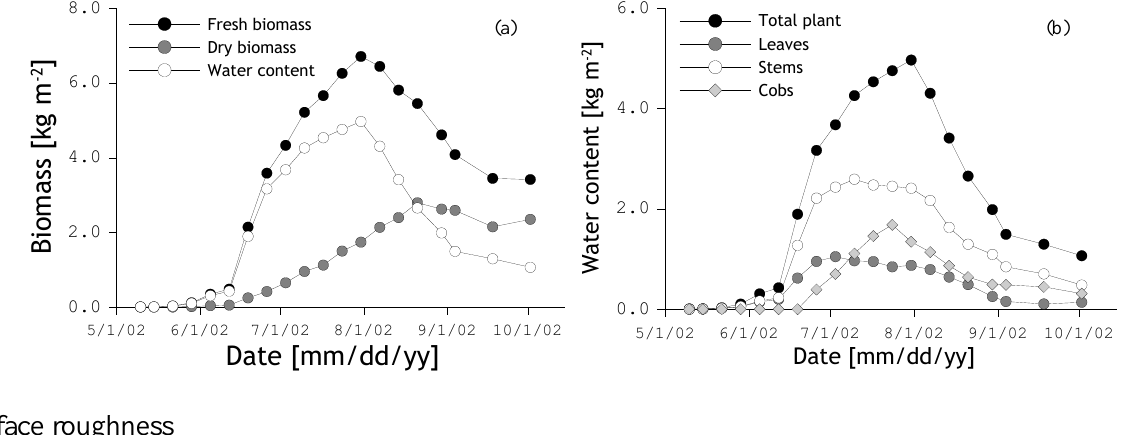
Figure 4. (a) Total plant water content, fresh and dry biomass plotted against time. (b) Water content in the leaves, stems and cobs plotted against time. The markers indicate the dates at which measurements were